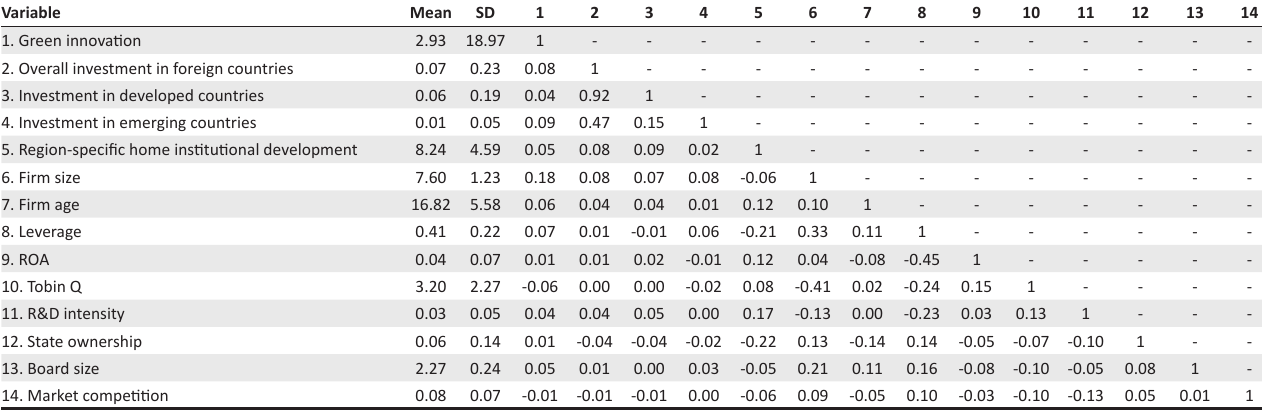
TABLE 1: Descriptive statistics and correlations ( N = 14 129).